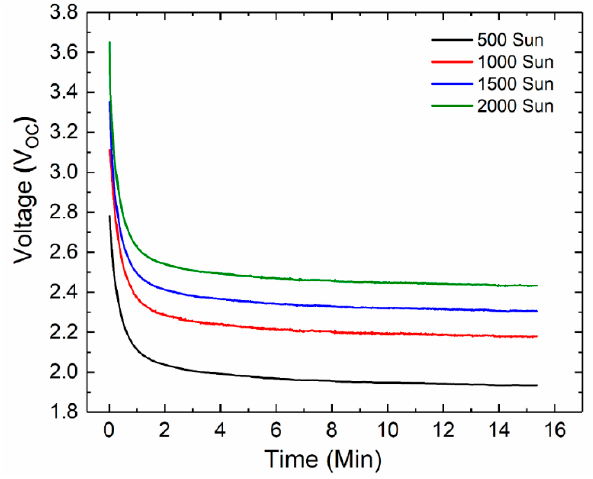
Figure 6. Open-circuit voltage as the function of time for the multi-junction solar cell under concentrated illumination corresponding to 500, 1000, 1500, and 2000 suns.